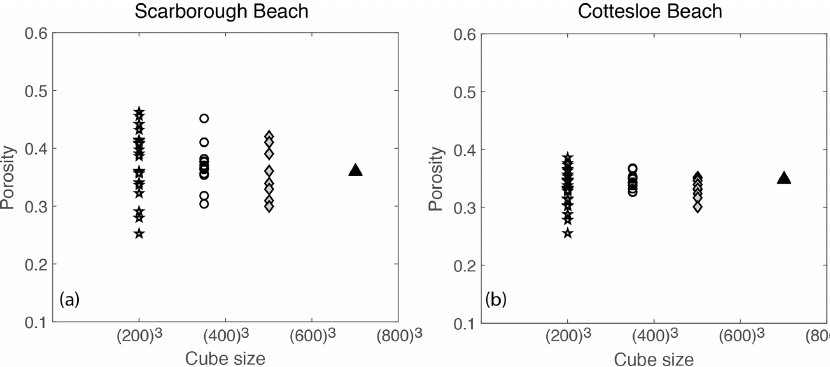
Figure 12. Porosity against cube sizes for (a) Scarborough Beach and (b) Cottesloe Beach.